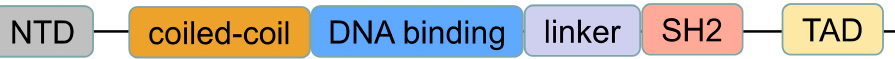
Figure 2. The structure of STAT. Schematic illustrating the conserved domain structure of STAT, including N-terminal domain (NTD), coiled-coil domain, DNA binding domain, transcriptional activation domain, SH2 domain, tyrosine activation domain (TAD). Figure prepared using information from various sources [20,26].